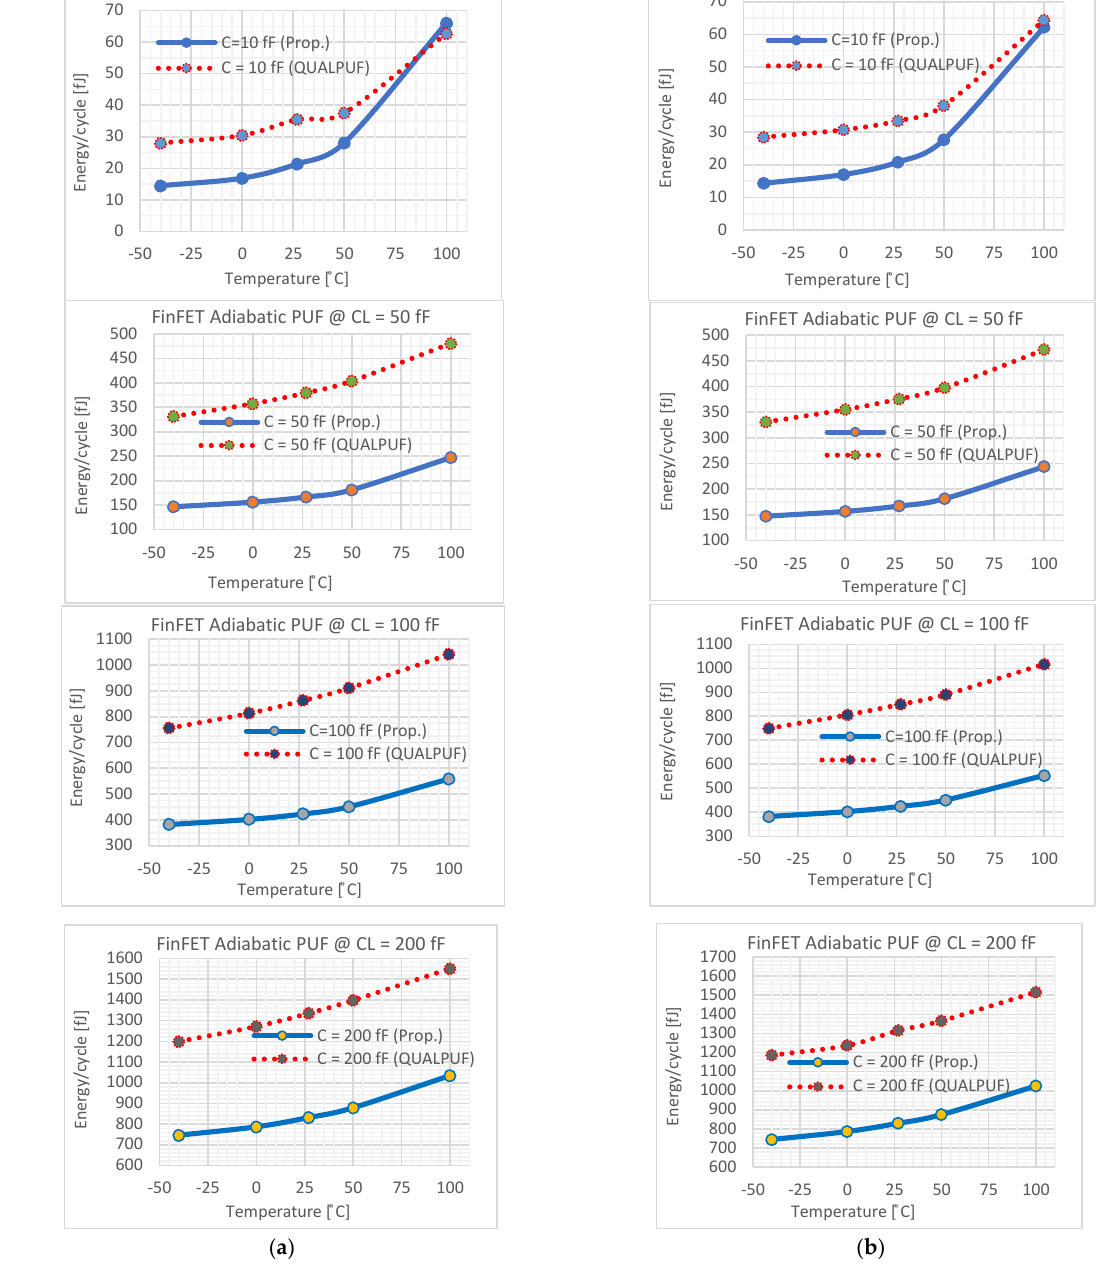
Figure 7. Energy consumption: ( a ) 10% of TOX variation and ( b ) 10% of V TH variation, with load capacitance varying from 10 to 200 fF.